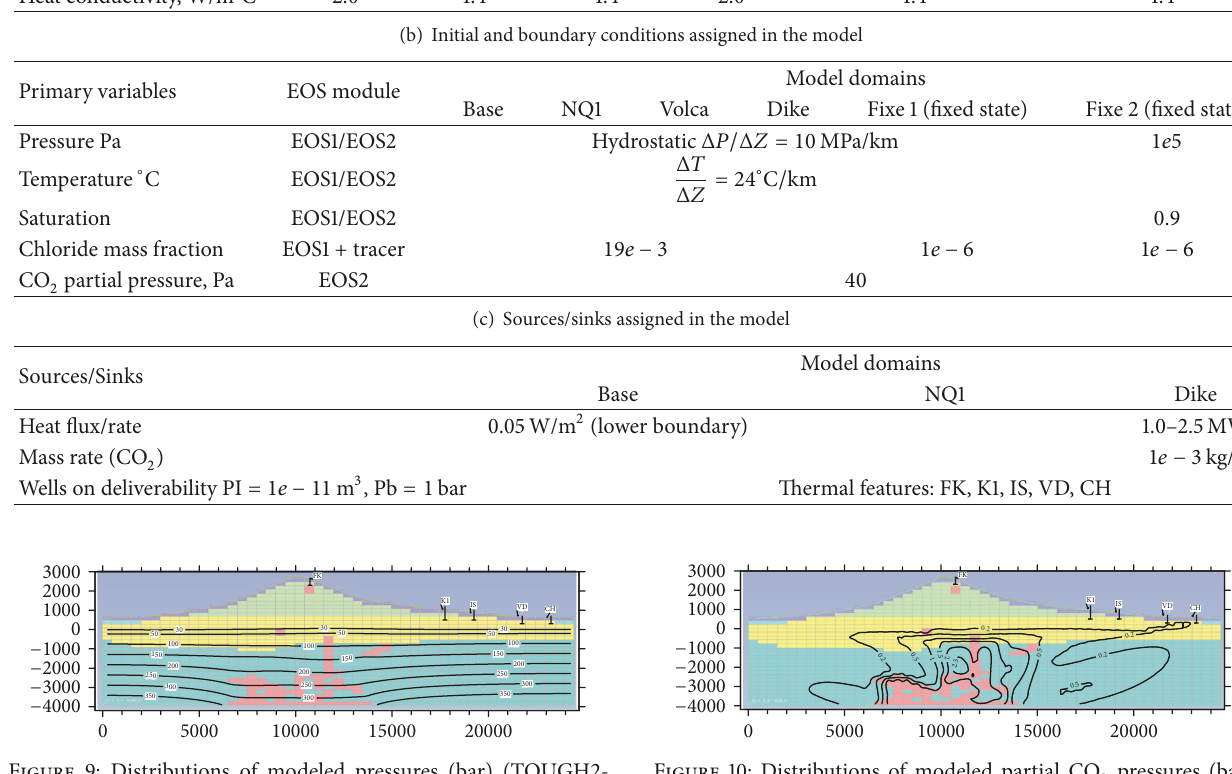
Figure 10: Distributions of modeled partial CO 2 pressures (bar) (TOUGH2-EOS2) (CO2-8). Horizontal and vertical axes are labeled in